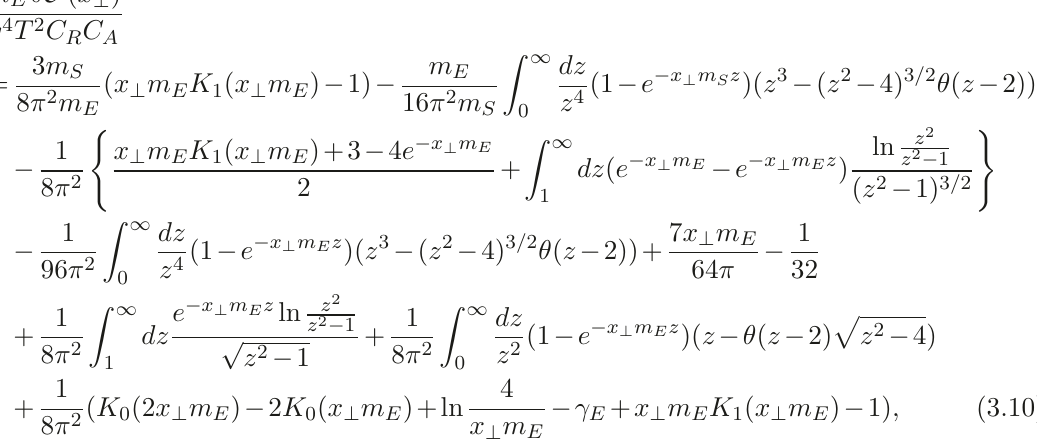
′ ( x Figure 5 . ⊥ ) /λT as a function of x ⊥ m E . The solid blue line is the LO expression, eq. (3.9), C while the red lines are given by the sum of eqs. (3.9) and (3.10). (NLO) ( x (LO) ( x NLO we obtain ) = ) + δ ( x ), with the NLO correction given by C ′ C ′ C ′ ⊥ ⊥ ⊥ m E δ ( x C ′ ⊥